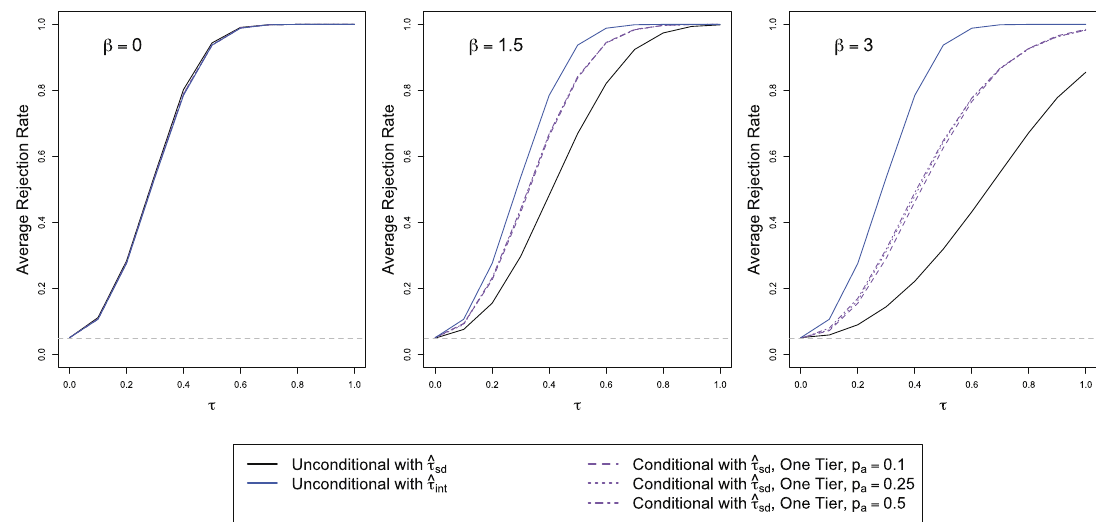
Figure 4: The rejection rate of the same tests discussed in Figure 1b, but for one or two tiers instead of four.